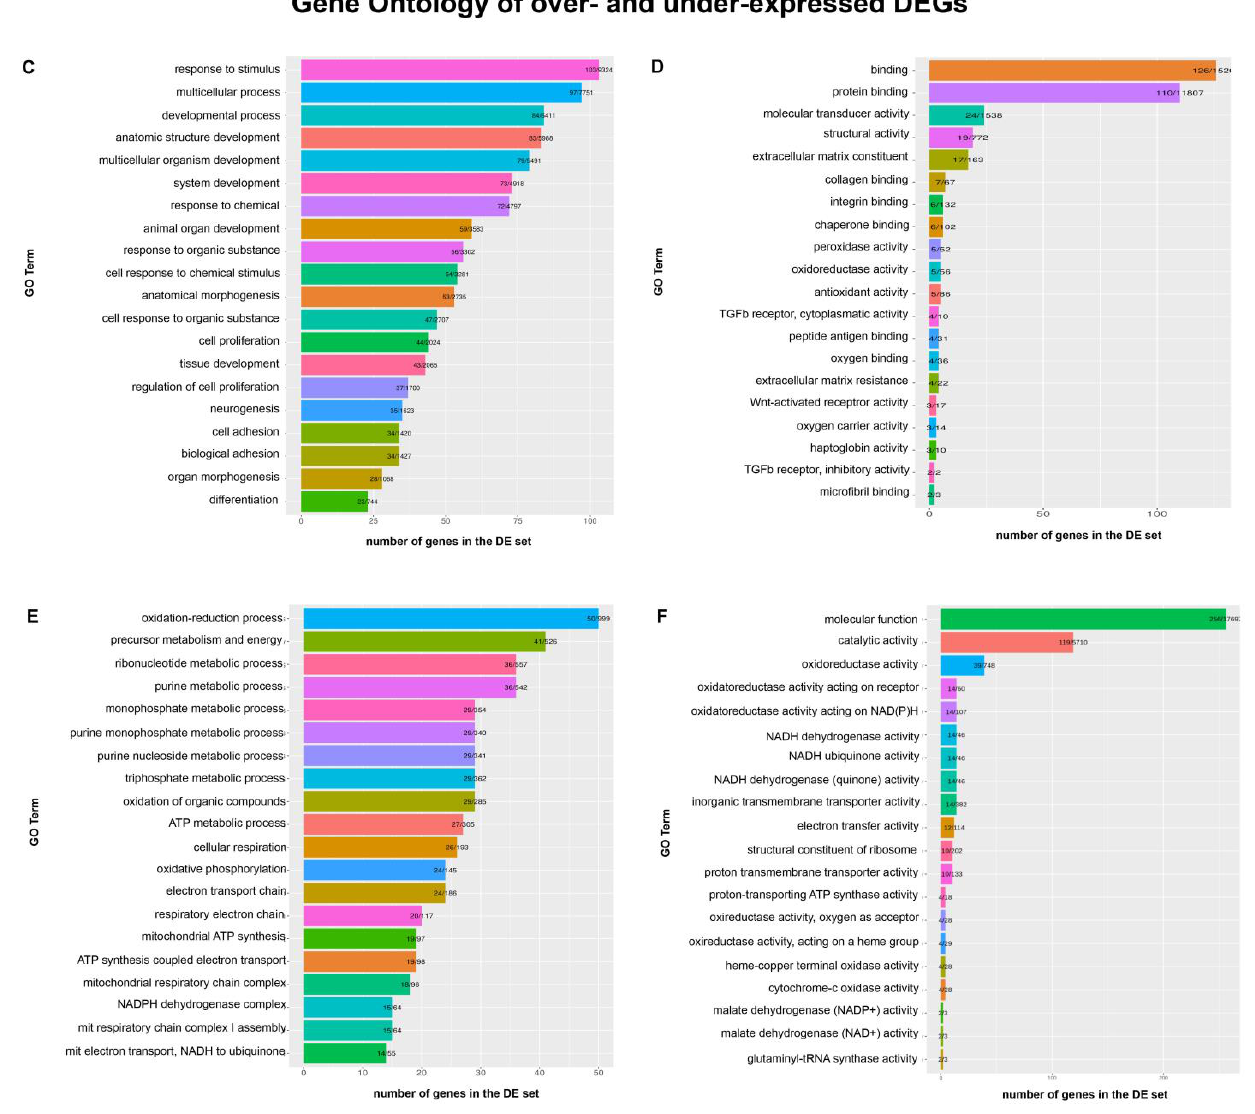
Figure 2. ( A ) Volcano plot displaying differential expressed genes (DEGs) between DCM patients and healthy subjects (HS). The y-axis is related to the mean expression value of log10 P and the horizontal x-axis displays the log2 fold change (log2FC) value. Positive and negative x-values represent up- and down-regulation, respectively. We highlighted in red the genes with a FC of ±1 and Log10 P > 2. ( B ) Heatmap displaying expression levels for a subset of n.48 DEGs (FDR < 0.05, logFC > 1/logFC < −1 ) related to DCM patients. ( C – F ) Gene Ontology plots of over-expressed ( C , D ) and under-expressed terms ( E , F ). The first n.20 Biological Process (BP) and n.20 Molecular Function (MF) terms organized by gene number for each term and with increasing p -value.